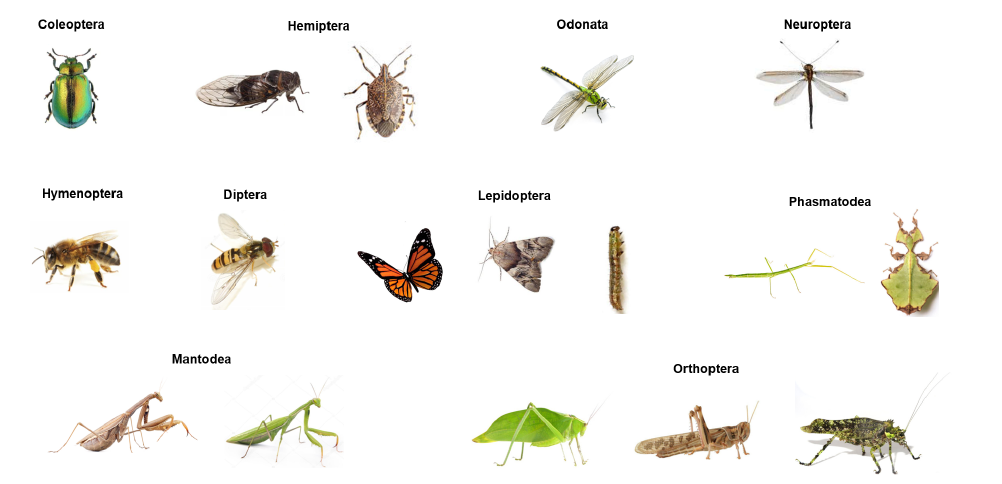
Figure 2. Specimens of typical camouflaged insects.